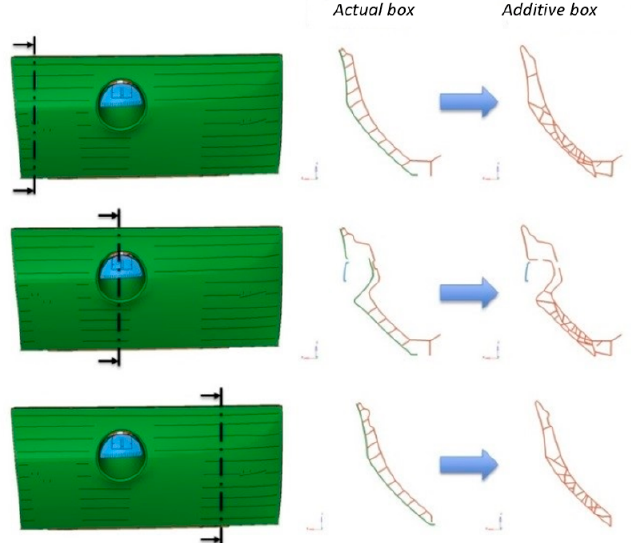
Figure 1. Sections of the actual (realized through molding) and the additive glove box.